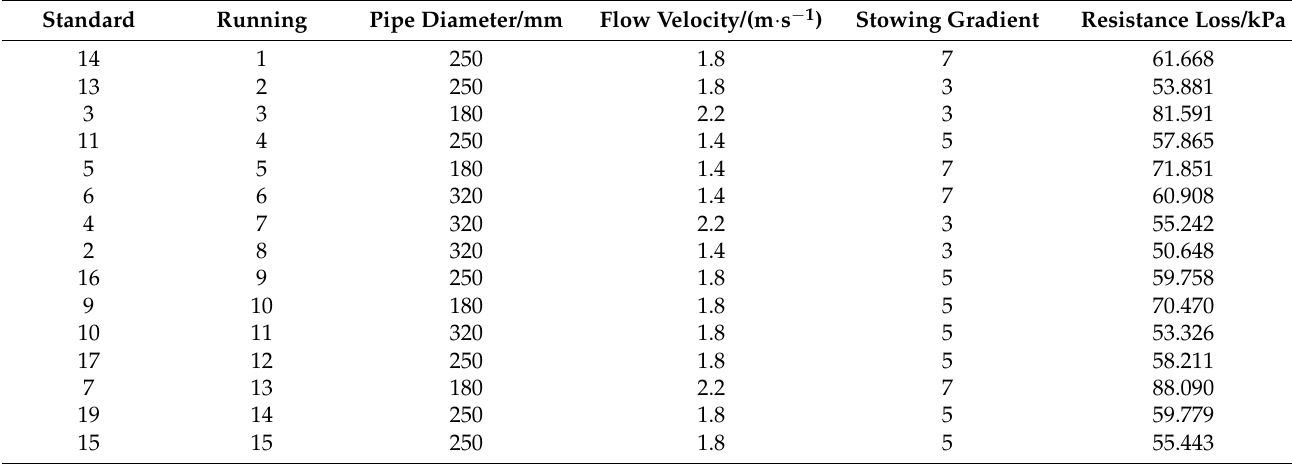
Table 9. Response surface results of exogenous factors